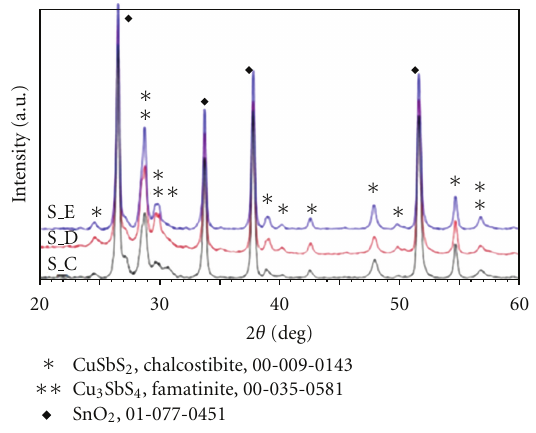
Figure 1: XRD spectra recorded for samples C, D, E. of the chemical bounds in the precursors, followed by nucle- ation and crystal growth.